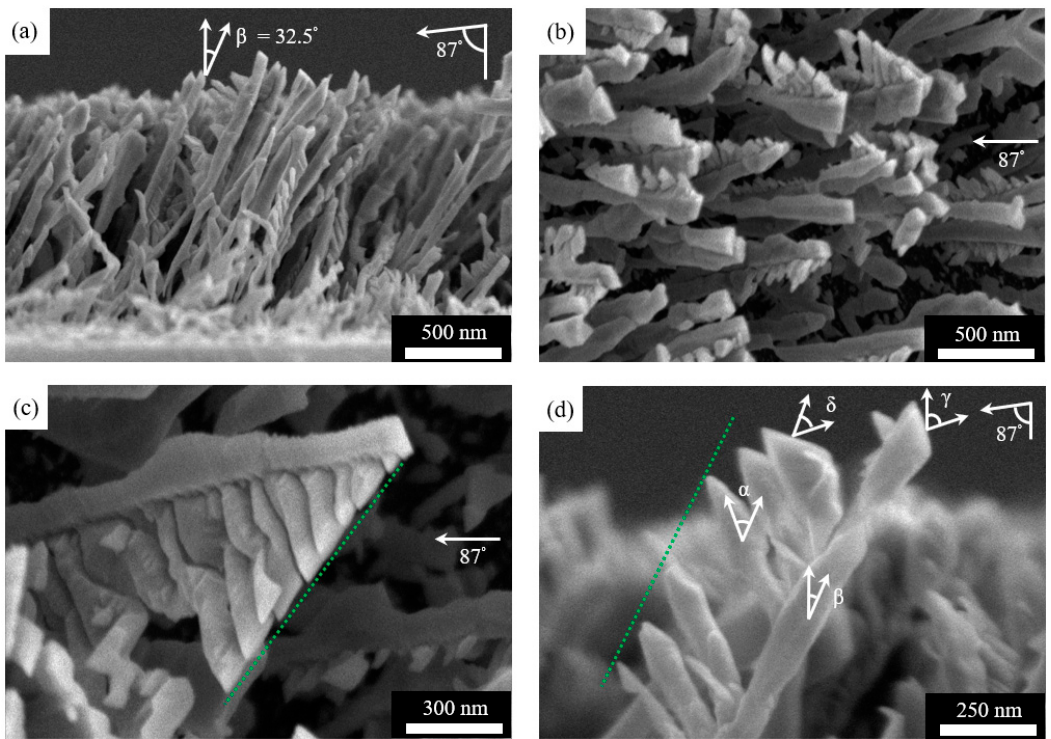
Figure 2. SEM images of Ti nanorods of ( a ) cross-section view and ( b ) top view, with the incidence angle of 87° and nanorod tilt angle of 32.5° shown. ( c ) Nanorod with the dotted line highlighting the increasing branch length. ( d ) Nanorod showing various angles, with the dotted line highlighting the constant length far away from the nanorod tip.